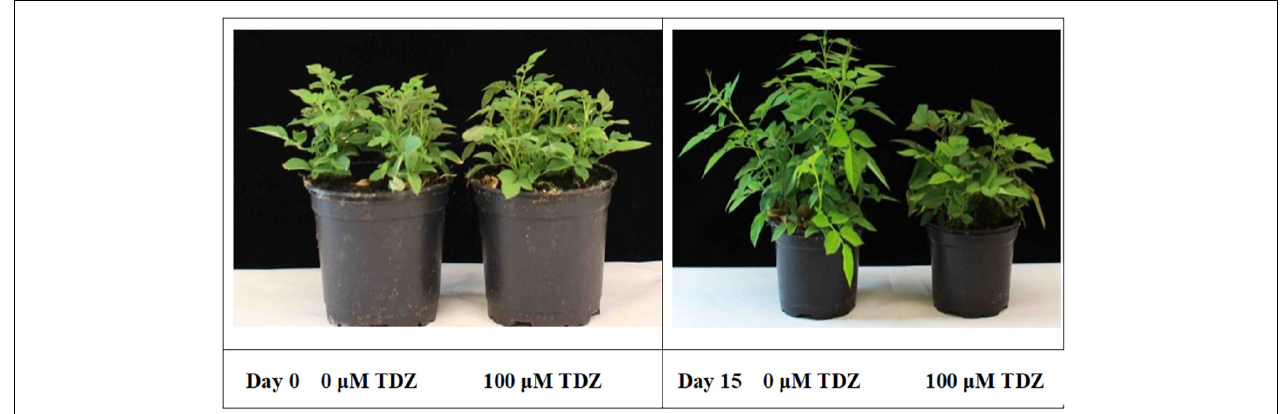
FIGURE 2 | Effects of TDZ application on shoot growth of potted rose plants. Plants on the day of TDZ treatment (left) and 2 weeks after spraying with 0 (control) and 100 µ M TDZ (right) .